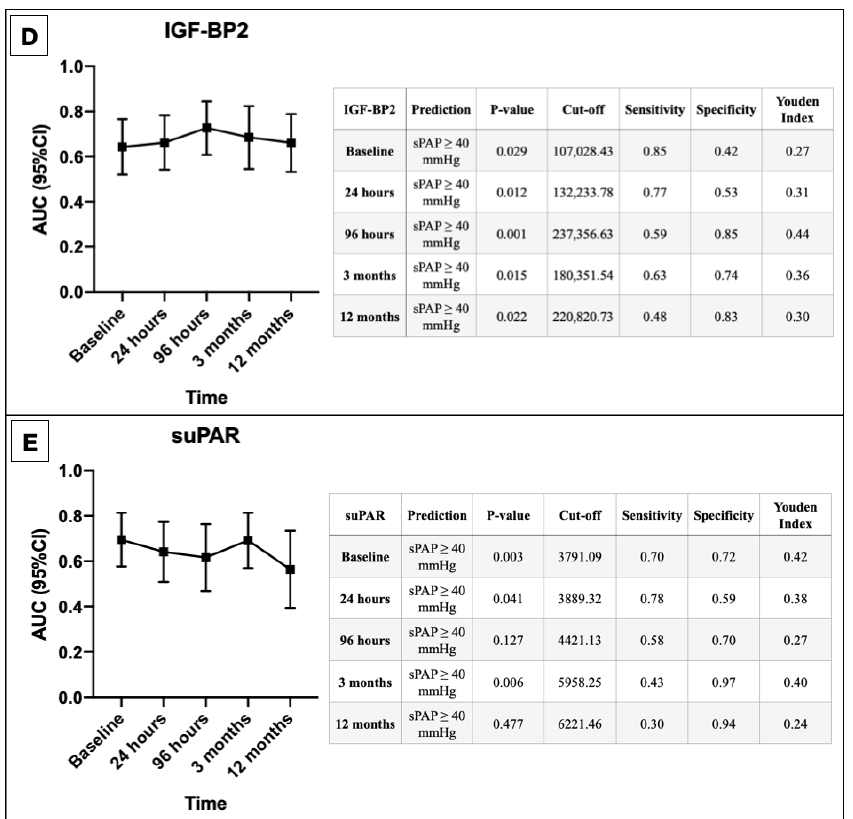
Figure 2. AUROC curves, cut-off values, and Youden Index for prediction of presence or absence of PH up to 12 months after TAVR. ( A ): sST2; ( B ): GDF-15; ( C ): H-FABP; ( D ): IGF-BP2; ( E ): suPAR. sST2: soluble suppression of tumorigenicity-2; GDF-15: growth differentiation factor-15; H-FABP: heart-type fatty acid binding protein; IGF-BP2: insulin-like growth factor binding protein 2; suPAR: soluble urokinase-type plasminogen activator receptor.